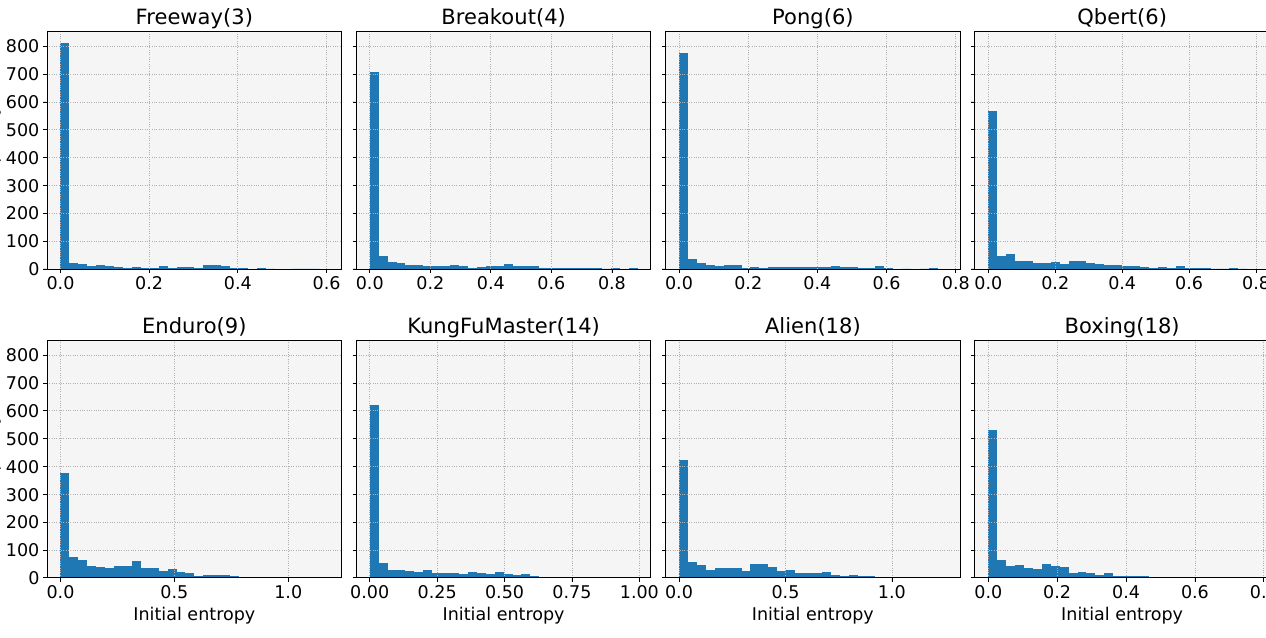
Figure 4. The histograms of the initial entropy for eight tasks. For each task, 1000 models were generated using an orthogonal initializer with different random